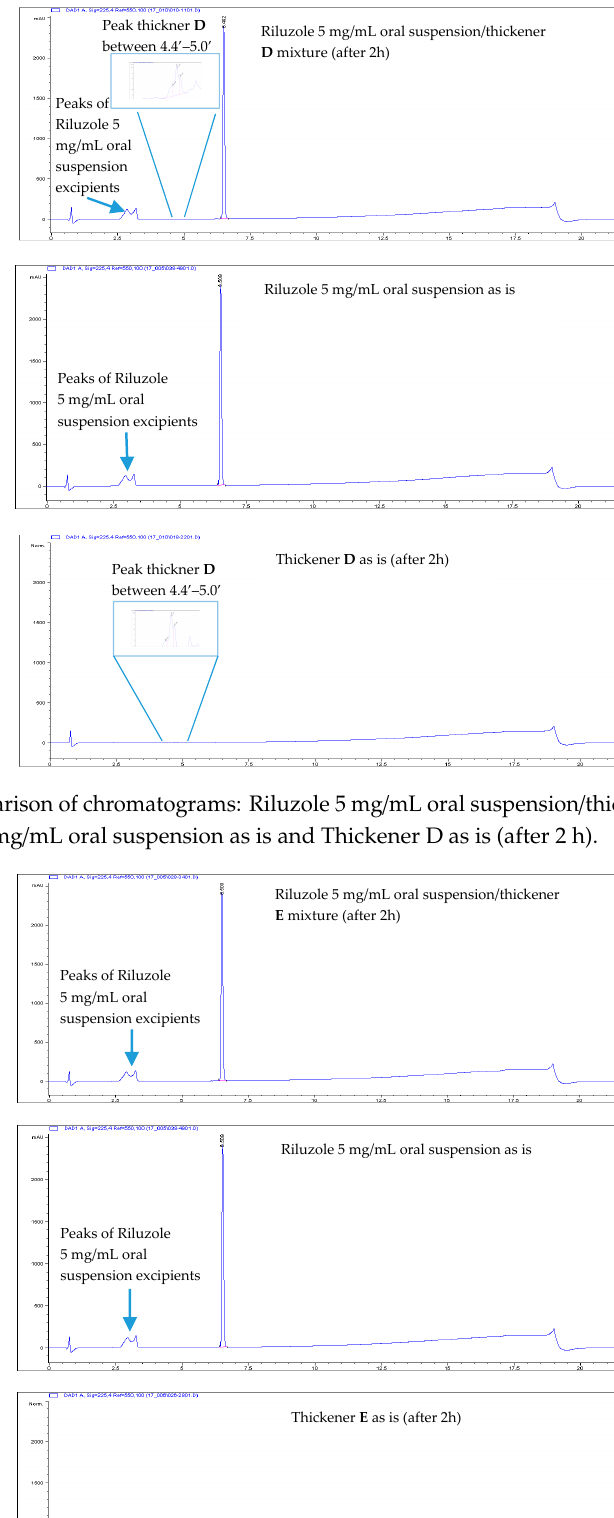
Thickener E as is (after 2h)